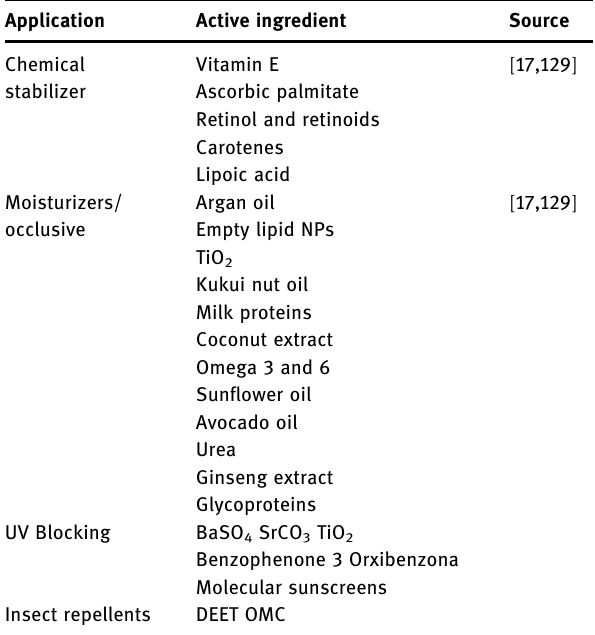
Table 6: Cosmeceutical application of lipid NPs